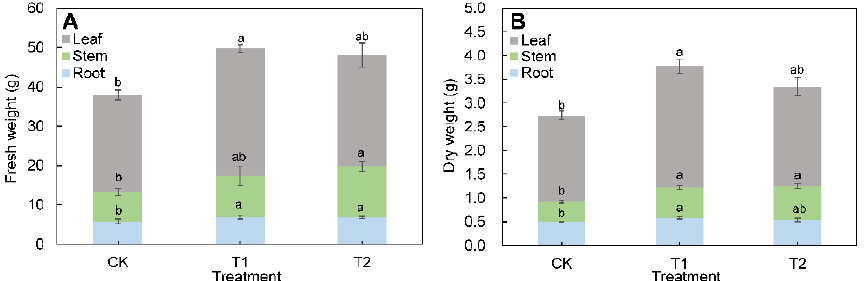
Figure 3. Fresh weight ( A ) and dry weight ( B ) of tomato plants exposed to different LED light supplementation durations. Data are expressed as average values ( n = 3). Different lowercase letters indicate significant differences between treatments determined using Duncan’s multiple range test ( p < 0.05). Standard errors are indicated by bars. CK: no light supplementation or control; T1: light supplementation for 3 h in the morning; T2: light supplementation for 3 h in the evening.